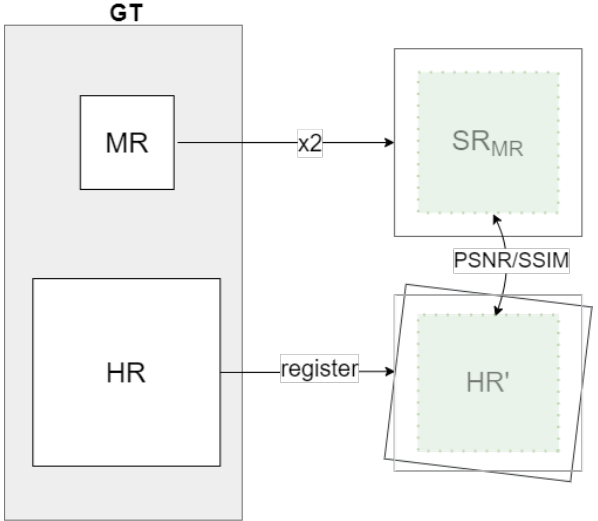
Figure 6. Illustration of the Evaluation 2 criteria from PBVS-CVPR2021 challenge [17] (mid- to high-resolution domain